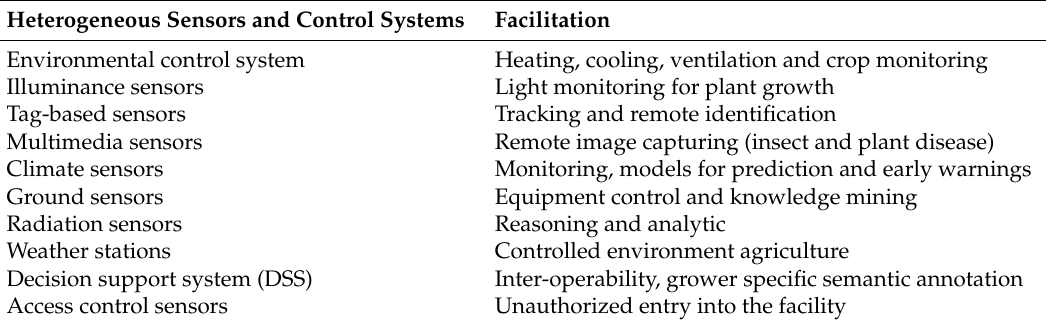
Table 2. Leveraging divergent sensors and control systems for PA in